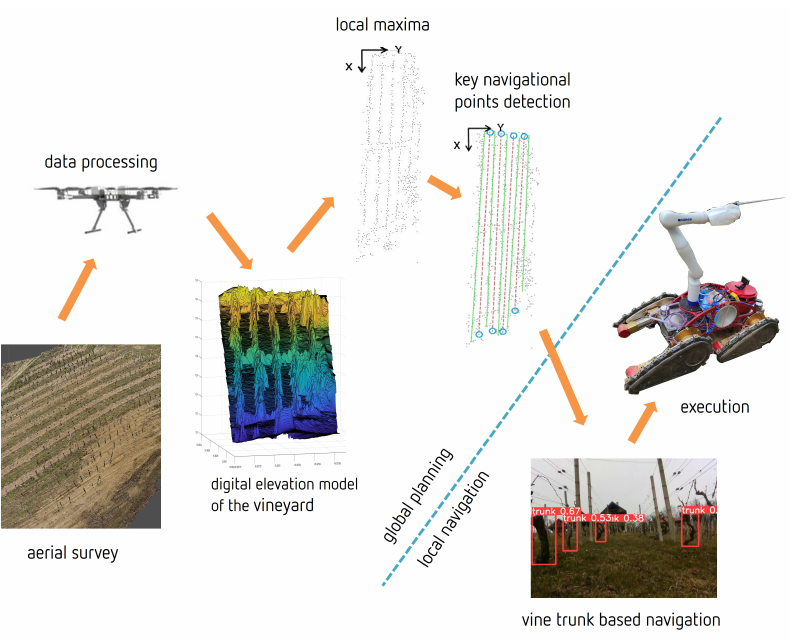
Figure 3. Schematic overview of the navigation operation of a heterogeneous HEKTOR viticulture robot system. Global planning provides ATMM-VIV the entry points into the aisles (marked with blue circle). Planning and navigation through the aisles is based on local features: vine trunks.